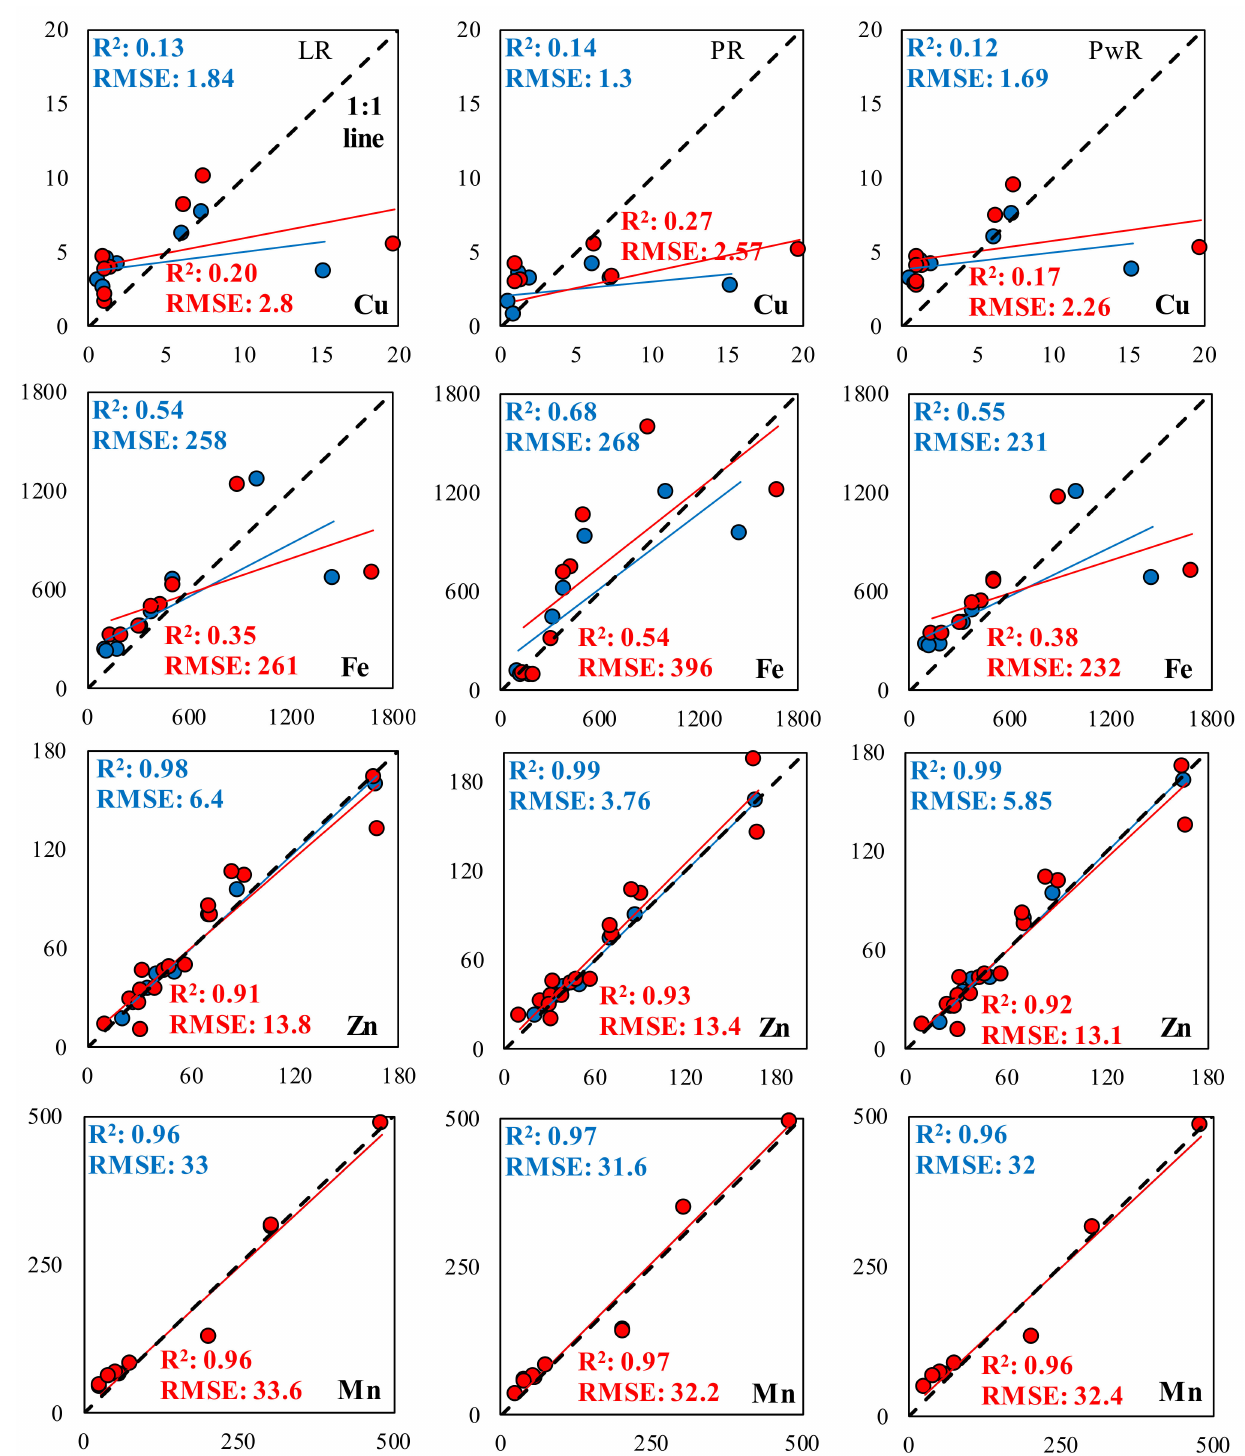
Figure 2. The relationship between observed ( x -axis) and predicted values ( y -axis), shown in mg kg − 1 , of the nutrient contents (Cu, Fe, Zn, and Mn) of plant samples. RMSE—root mean square error. The observed values are the actual values obtained, and the predicted values are the values of the variable predicted, based on the regression analysis. Blue and red points are ‘modeling’ and independent (‘validation’ samples) datasets of measurements, respectively. Black dashed lines represent the 1:1 line, and blue and red solid lines represent the actual regression curves from the ‘modeling’ and ‘independent’ datasets,